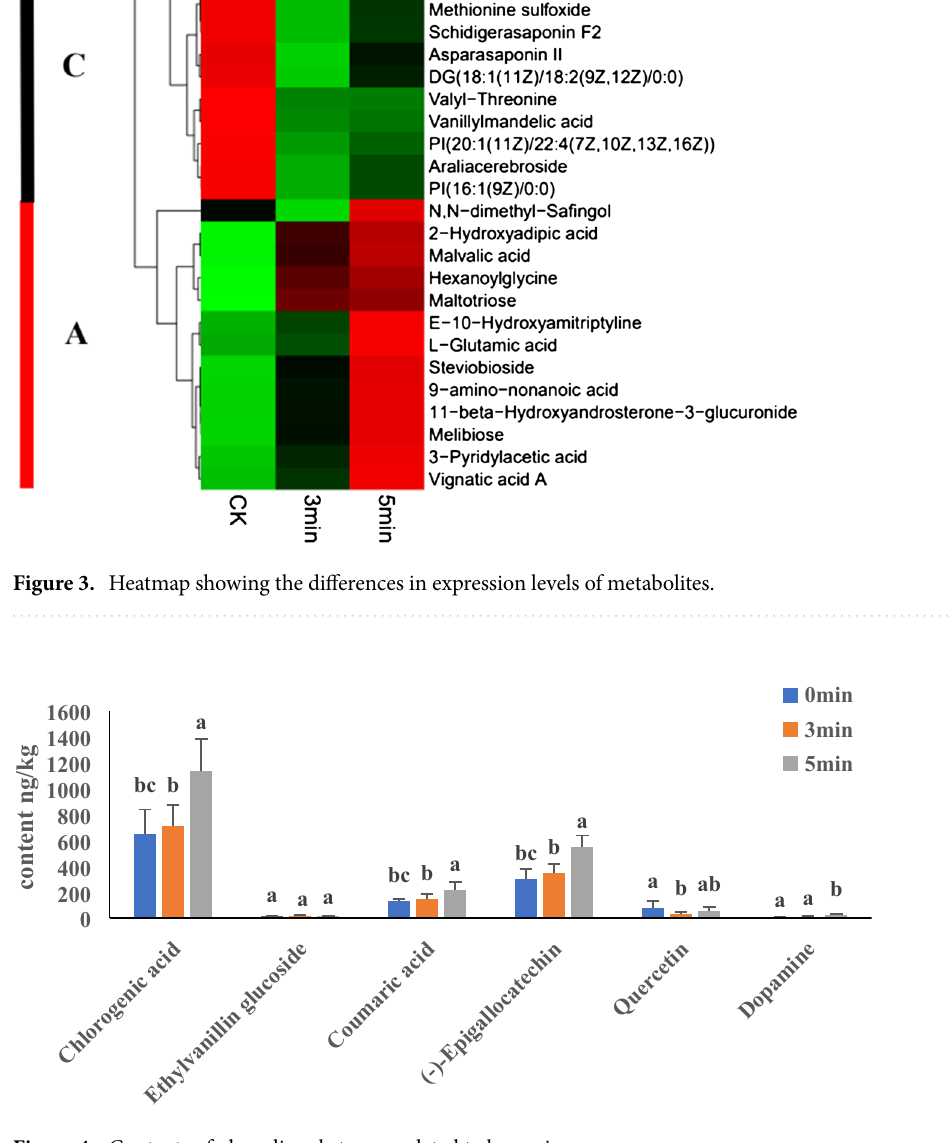
Figure 4. Contents of phenolic substances related to